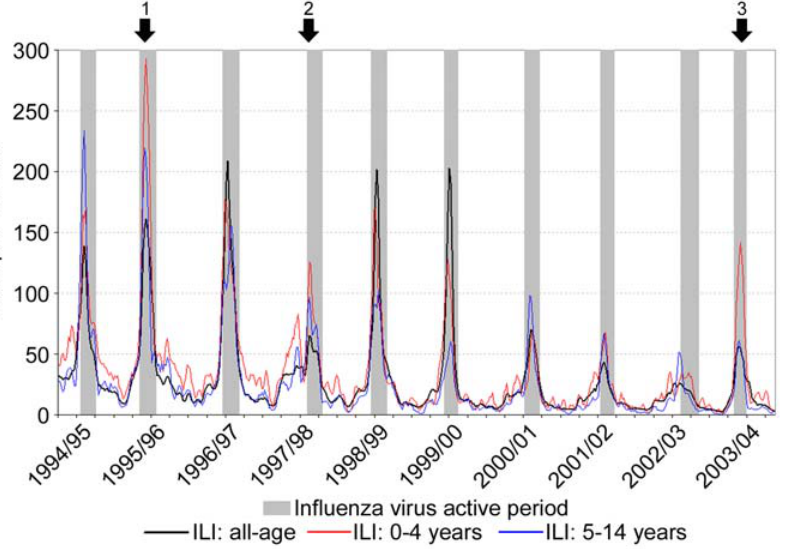
Figure 2. Clinical incidence rate of influenza-like illness (ILI) per 100,000 population recorded by the Royal College of General Practitioners Weekly Returns Service. Weekly incidence rate of ILI presented for all-age, 0–4 and 5–14 years age groups. Vertical shaded bars represent defined periods of influenza virus circulation derived from laboratory reports.[8] Arrows indicate those years in which a new variant was introduced into the community (1. A/Wuhan/359/95; 2. A/Sydney/5/97; 3.